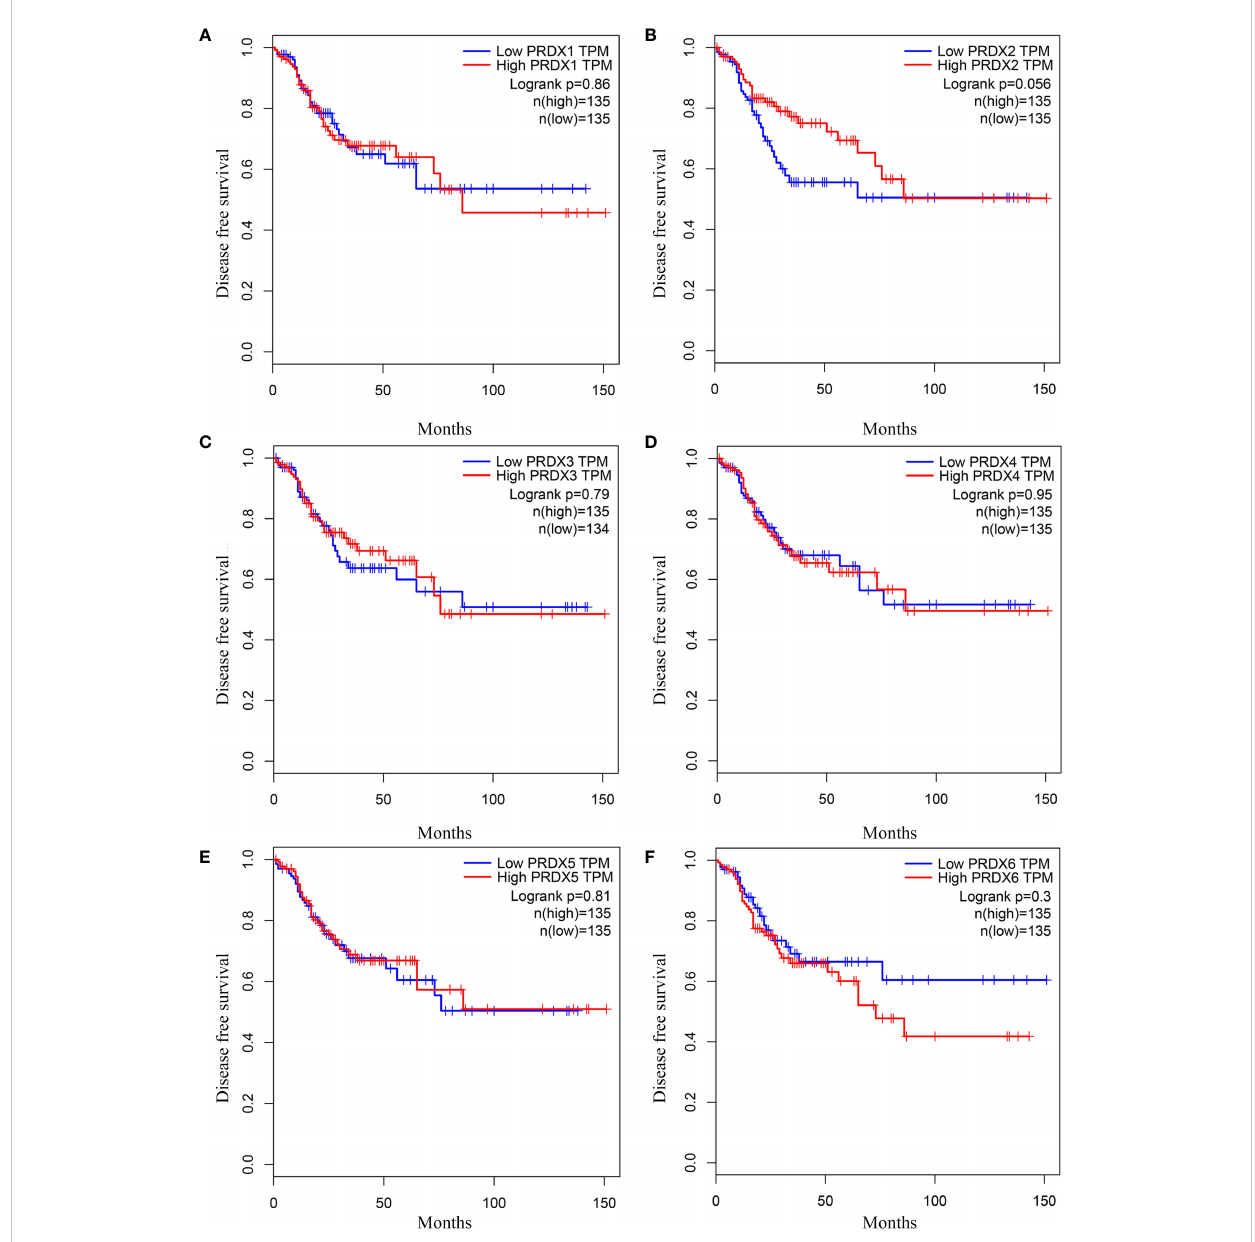
FIGURE 5 The DFS curves of PRDXs in COAD (GEPIA). (A-F) None of the PRDX family members were associated with DFS in COAD ( P > 0.05). DFS, disease free survival; COAD, colon